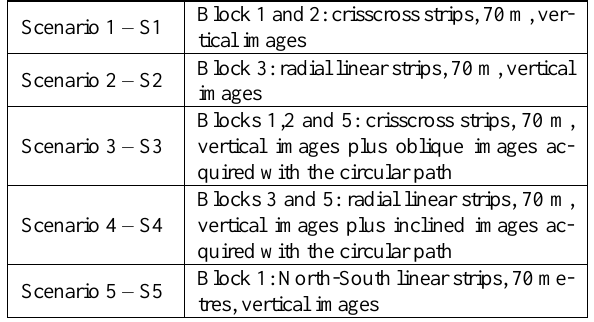
Table 3. The scenarios analysed in the paper